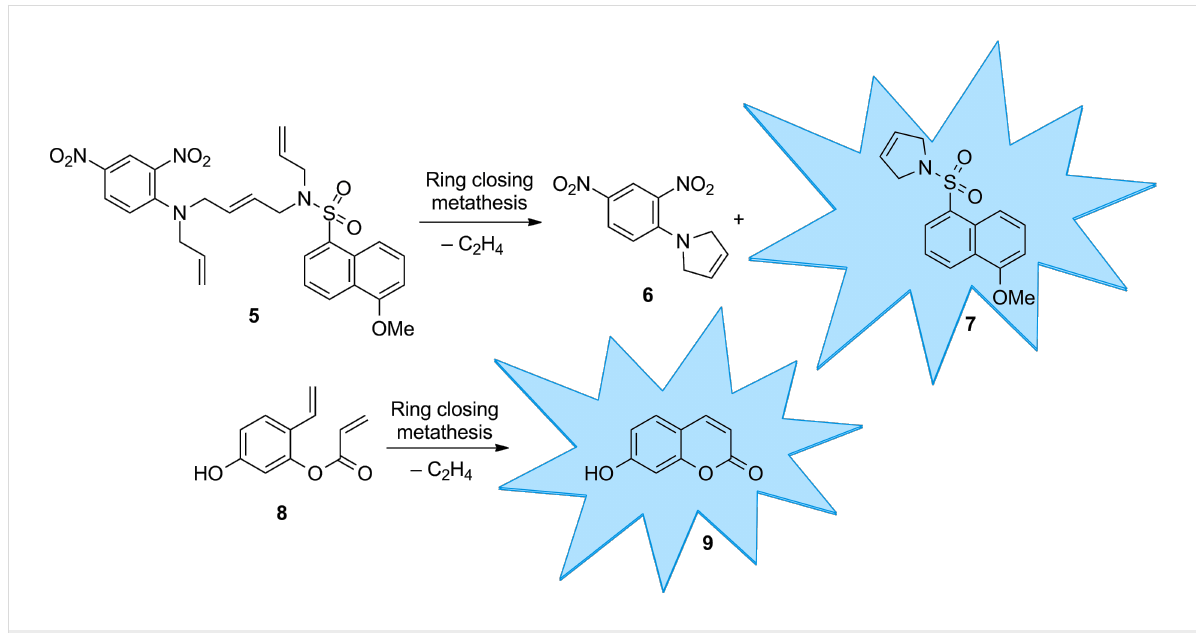
dinitroaniline core, acting as a fluorescence quencher [17]. Both the sulfonamide of the fluorophore and the aniline group of the quencher bear another allyl group. Upon relay ring-closing metathesis, the fluorophore and quencher are disconnected resulting in the fluorescent product 7 . A similar linker concept has previously been implemented for a solid-phase linker in the synthesis of oligosaccharides [18,19]. The second profluores- cent molecule selected was diolefin 8 , which yields fluorescent 7-hydroxycoumarin (umbelliferone) ( 9 ) upon ring-closing metathesis. The synthesis of coumarin derivatives using this ap- proach was described in previous publications [20,21]. By intro- ducing an electron donor in the 7-position, a fluorescent prod- uct is obtained upon ring-closing metathesis